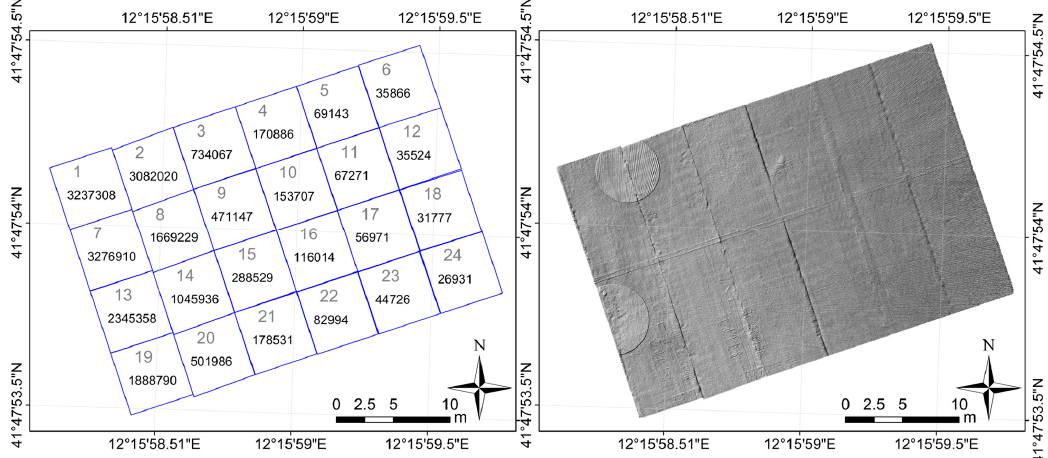
Figure 2. Left panel : Partition in slabs of the piece of apron studied along with the numeration used and the number of points belonging to each slab. Right panel : DEM displayed in “shadow relief” mode.